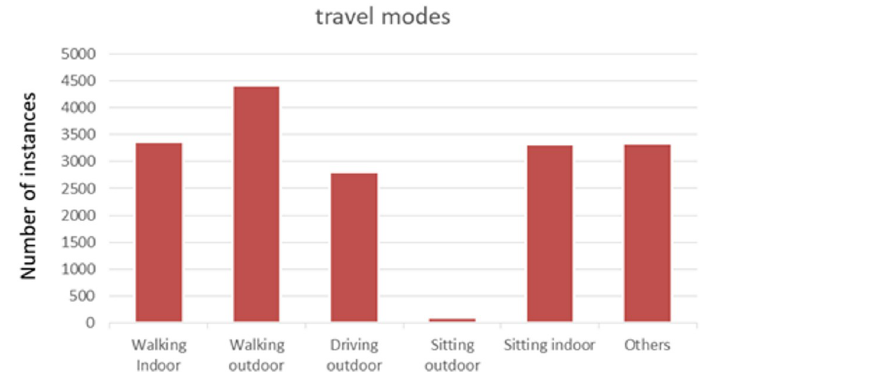
Fig 2. Travel modes in manually annotated set of images.